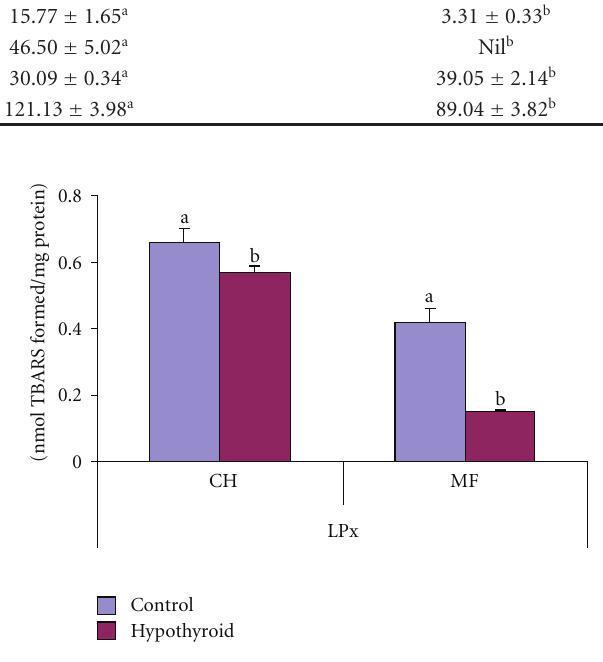
Figure 1: E ff ect of neonatal PTU treatment on lipid peroxidation (LPx; nmol TBARS formed/mg protein) in crude homogenate (CH) and mitochondrial fraction (MF) of testes of rats. Data are expressed as mean ± S.D. of 5 observations and subjected to unpaired Student’s t -test. Statistical significance was accepted at P < 0 . 05. Control and hypothyroid groups were found to di ff er signifi- cantly at P < 0 . 05 as represented by superscripts of di ff erent letters. Control (Group-I): 30-day-old control rats; hypothyroid